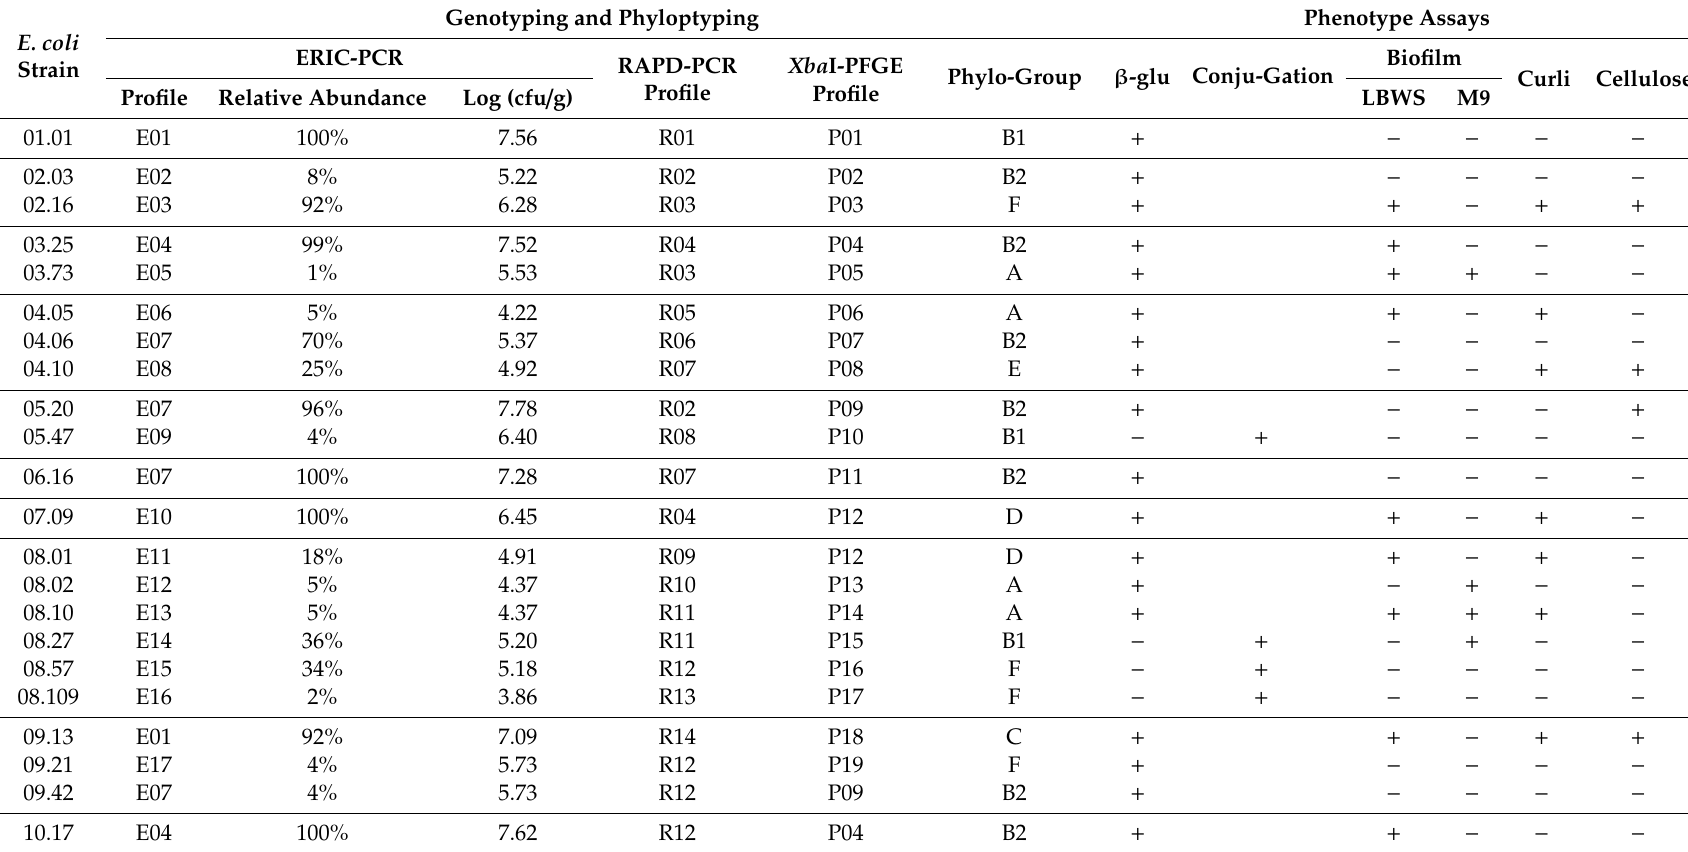
Table 1. E. coli isolates from 20 healthy subjects. The strains were genotyped by ERIC-PCR, RAPD-PCR, and PFGE analysis. The relative abundance represents the ratio of each strain within the set of E. coli clones analyzed. The charge of the viable cells has been calculated by multiplying the total E. coli count and the relative amount. Phlylotyping was done according to Clermont et al. 2013 [17]. The presence of β -glucuronidase was confirmed by growth of blue colonies on the HCCA medium. The performance of isolates as recipients in conjugation experiments was assessed only in β -glucuronidase negative strains. Biofilm formation was tested on LBWS and M9glu media. Curli and cellulose production was